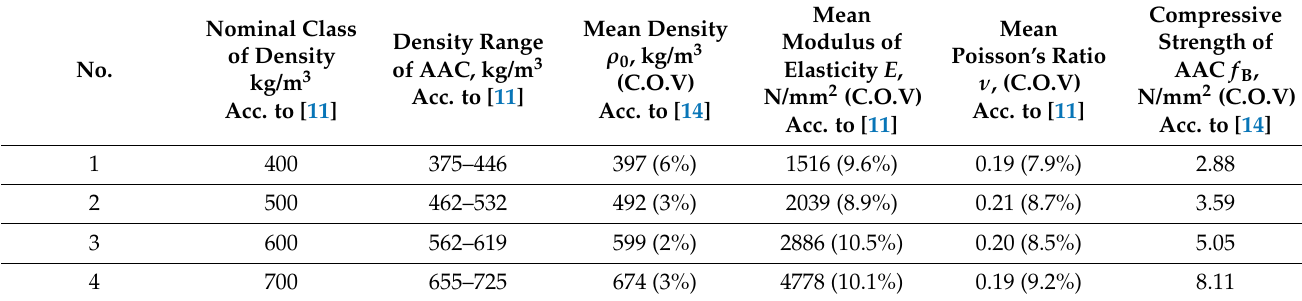
Table 1. Fundamental characteristics of masonry units as defined in the papers